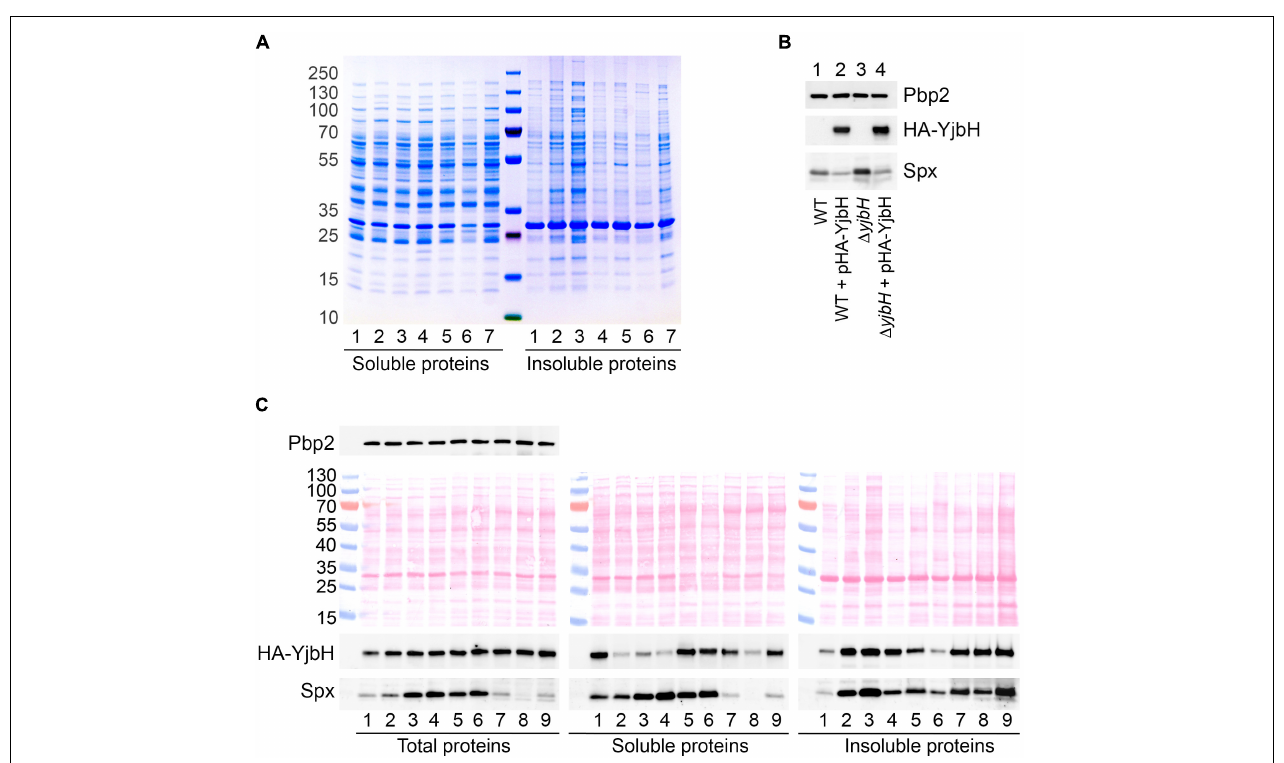
FIGURE 3 | HA-YjbH is aggregated upon heat shock, oxidative stress and antibiotic treatment. (A) Exponentially growing cells (1) were treated with high temperature of 53 ◦ C (2), 10% of ethanol (3), 5 mM of diamide (4), 10 µ g/ml of oxacillin (5), 10 µ g/ml of vancomycin (6), and 50 µ g/ml of kanamycin (7). Whole cell extracts were adjusted to the same total protein concentration and fractionated into the soluble and insoluble fractions. Samples were separated by gradient (4–12%) SDS-PAGE, and analyzed by Coomassie Blue staining. (B) Cells, either wild type (WT) or (cid:49) yjbH were transformed with plasmid expressing HA-tagged YjbH (HA-YjbH). Whole cell extracts were prepared and the levels of HA-YjbH and Spx were estimated by western blot with anti-HA and anti-Spx antibodies. Penicillin binding protein 2, Pbp2, was used as a control for equal loading. (C) (cid:49) yjbH cells expressing HA-YjbH were not treated (1) or treated with high temperature (53 ◦ C) (2), 10% of ethanol (3), 5 mM of diamide (4), 40 µ g/ml of oxacillin (5), 40 µ g/ml of vancomycin (6), 400 µ g/ml of kanamycin (7), 60 µ g/ml of tetracycline (8), and 20 µ g/ml of erythromycin (9). Whole cell extracts were adjusted to the equal protein concentration and fractionated into the soluble and insoluble fractions. Proteins were separated by gradient (4–12%) SDS-PAGE and transferred to the nitrocellulose membranes. Membranes were stained with Ponceau S for detection of protein bands and control of loading, and analyzed by western blot with anti-HA, anti-Spx, and anti-Pbp2 antibodies. Pbp2 was used as a control for the equal protein amount in whole cell extracts. Western blots were quantified with ImageJ program and normalized to the signal in untreated control ( Supplementary Figure S1 ).